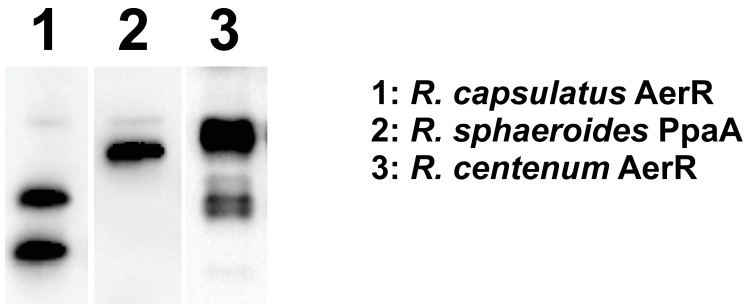
AerR (PpaA) expression pattern in other species.Western blot analysis of AerR(PpaA)−3xFLAG protein expression in Rhodobacter sphaeroides and Rhodospirillum centenum.